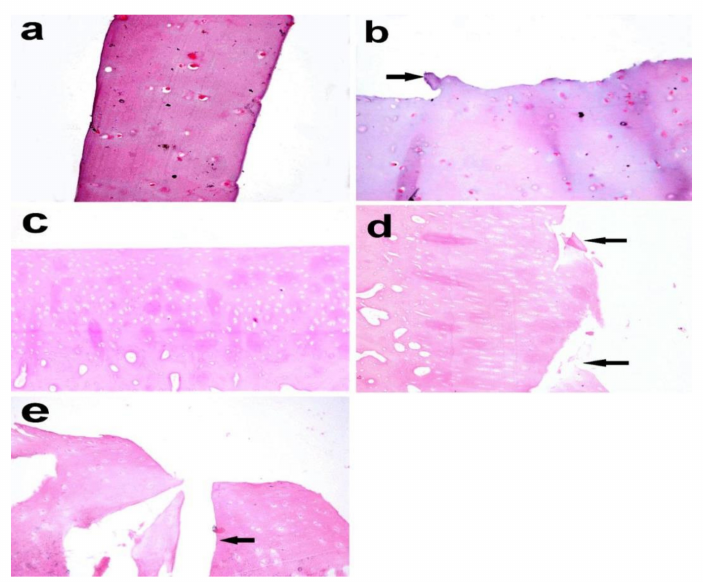
Figure 8. Articular cartilage biopsy of donkey. ( a ) Normal histologic features and a smooth surface in the control group (right radius articular cartilage), ( b ) uneven surface with superficial fibrillation (arrow) in theMIA-injected group (left radius articular cartilage) after 3 months (X 400). ( c ) Normal histological structure in which the matrix and chondrocytes are organized into superficial, mid, and deep zones. ( d ) Surface fibrillation and vertical branching fissures extending into mid-zone after 5 months (grade 3) (arrow). ( e ) Extensive erosion with excavation and loss of matrix in fissured domains (grade 4) after 7 months (arrow). (X 200), Haematoxylin and eosin stain.